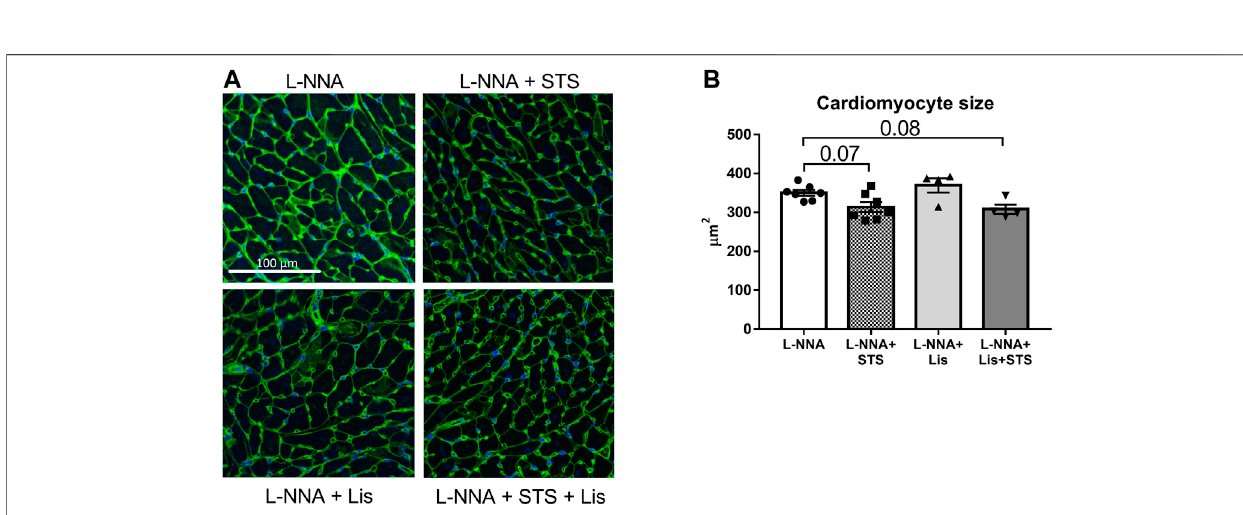
FIGURE 7 | Treatment with STS reduced cardiac fi brosis. Masson Trichrome stained cardiac sections were used to visualize collagen deposition. (A) Representative images and (B) quanti fi cation of the fi brotic area in the four groups. N (cid:2) 5 – 7. * p < 0.05, *** p < 0.001.